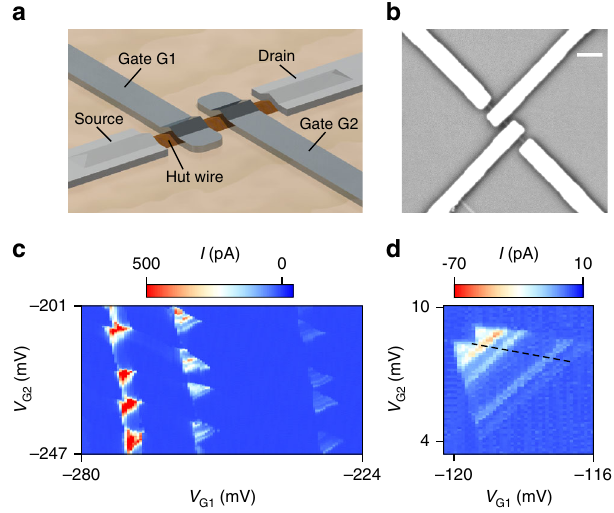
Fig. 1 DQD devices from Ge HWs. a Schematic showing a Ge HW contacted with source and drain electrodes and covered by two top gates (G1, G2). The hafnium oxide layer separating the HW from the gates is not shown. b Scanning electron micrograph of a device similar to the ones measured. The scale bar is 200 nm. c Stability diagram of DQD device A showing the characteristic bias triangles at a bias voltage of V SD = 2 mV. d Representative zoom-in of a pair of bias triangles at V SD = − 2 mV from device B. The dashed black line indicates the edge of the lower bias triangle